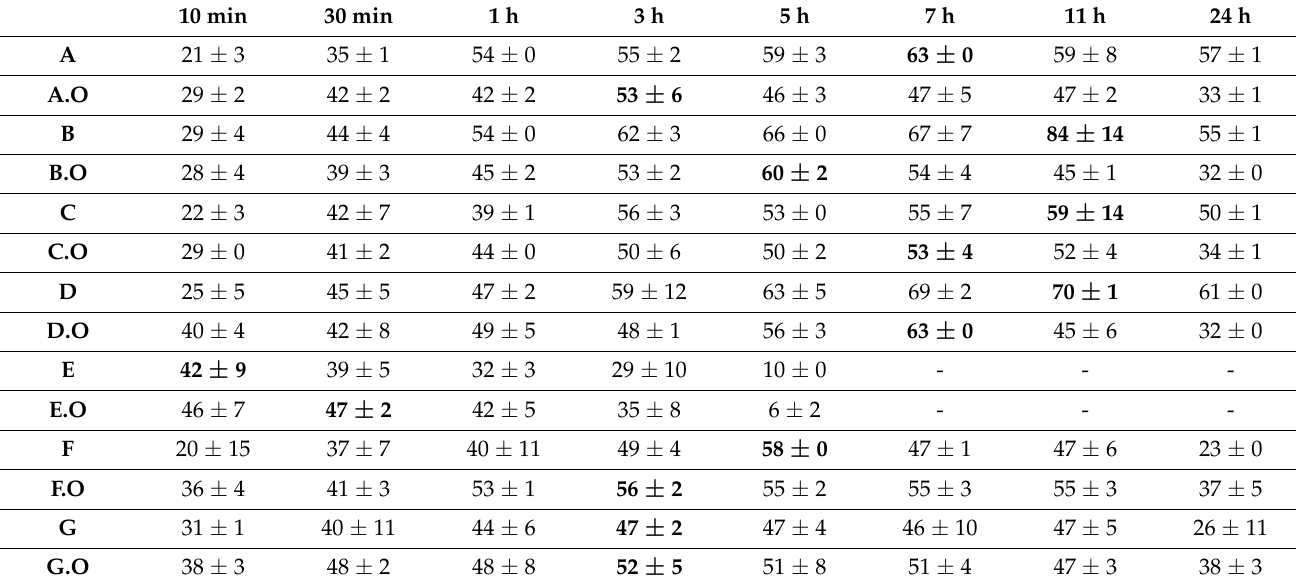
Table 3. Absorption efficiency (%) of mVFS of vaginal sheets over 24 h. Results are presented as mean value ± standard deviation (SD), n = 3. Bold values represent the maximum absorption (swelling) timepoint from which preparations start to lose their structure.